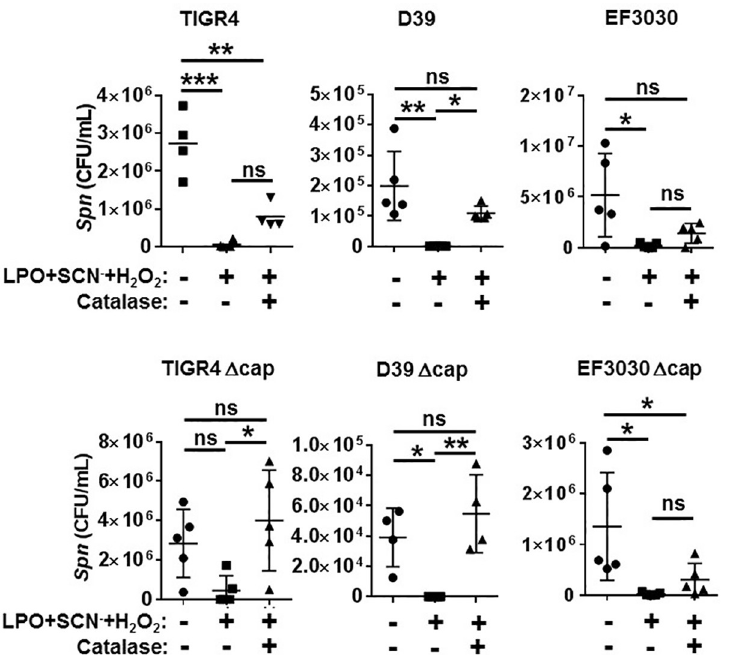
Fig 5. LPO-derived hypothiocyanite kills both encapsulated and nonencapsulated Spn strains. OSCN — mediated killing of Spn was tested in the cell-free system using 1st line TM against three encapsulated strains of Spn (TIGR4, D39 and EF3030) and their capsule-deficient, isogenic mutants ( Δ cap) in 4–5 independent experiments: n = 4 for TIGR4 and D39 Δ cap, n = 5 for the other strains. Bacteria were incubated for 6 hrs with or without OSCN - generated by the LPO/SCN - /H2O 2 system in presence or absence of catalase and bacterial killing was quantified by colony counts on BAP. Each symbol represents a separate, individual experiment, mean+/-S.E.M. is shown. ANOVA and Holm-Sidak’s multiple comparisons test. Each experiment was done in biological triplicates and each biological replicate was tested in technical triplicates. Ns, not significant; � , p < 0.05; �� , p < 0.01, ��� , p < 0.001. CFU, colony-forming unit; LPO, lactoperoxidase; OSCN - , hypothiocyanite; SCN - , thiocyanate; Spn , Streptococcus pneumonia ; CAT, catalase.